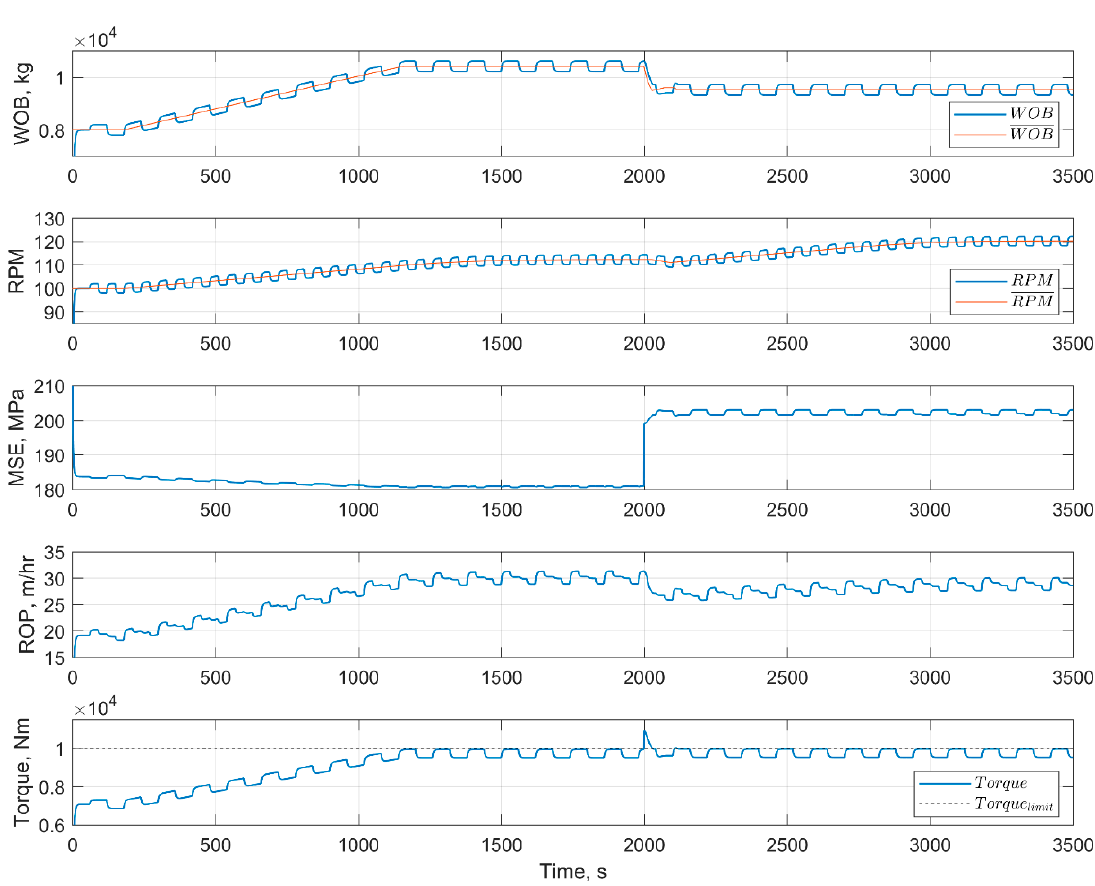
Figure 15. Simulation run 4, a scenario where the torque is not allowed to exceed 10,000 Nm.